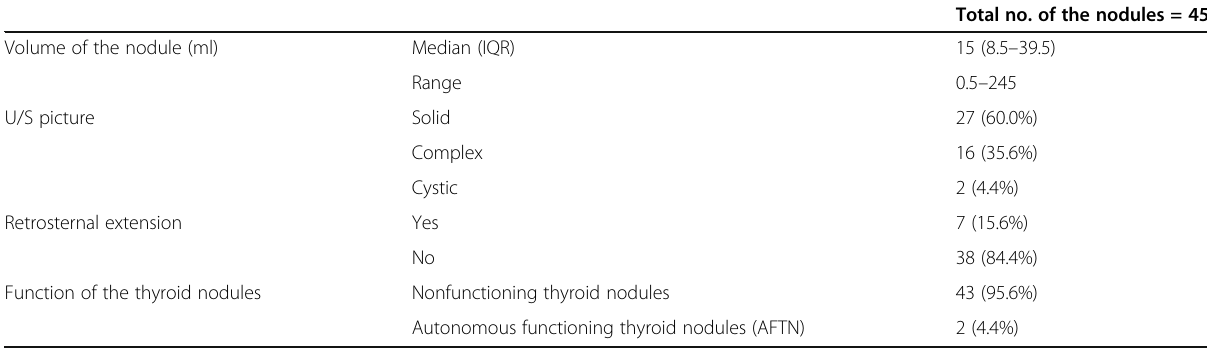
Table 2 Main characteristics of the 45 thyroid nodules of the 40 patients